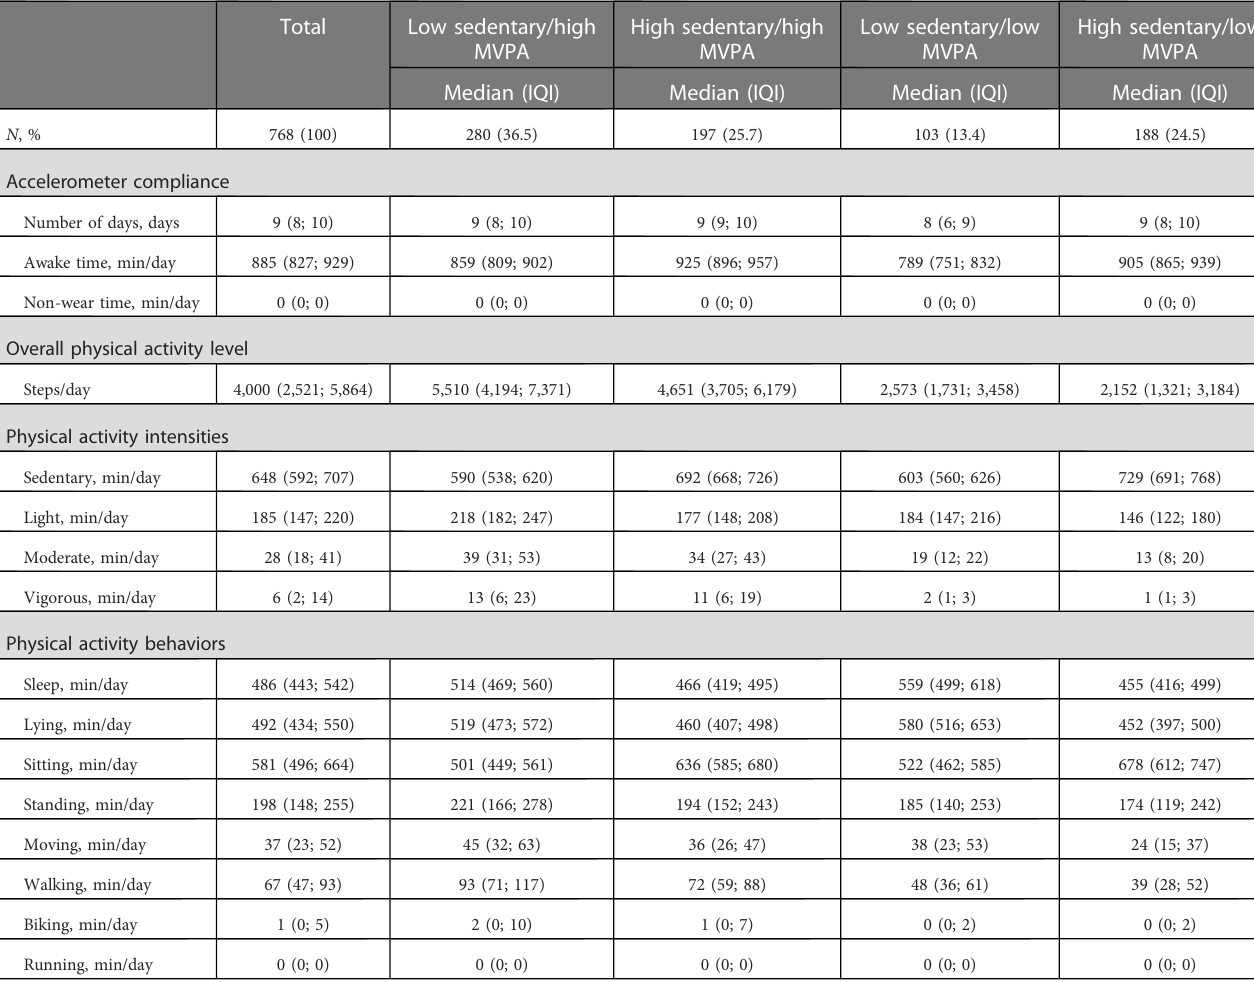
TABLE 2 Crude median estimation of physical activity volumes, intensities and behaviors in individuals with newly diagnosed type 2 diabetes strati fi ed by physical activity pro fi les.